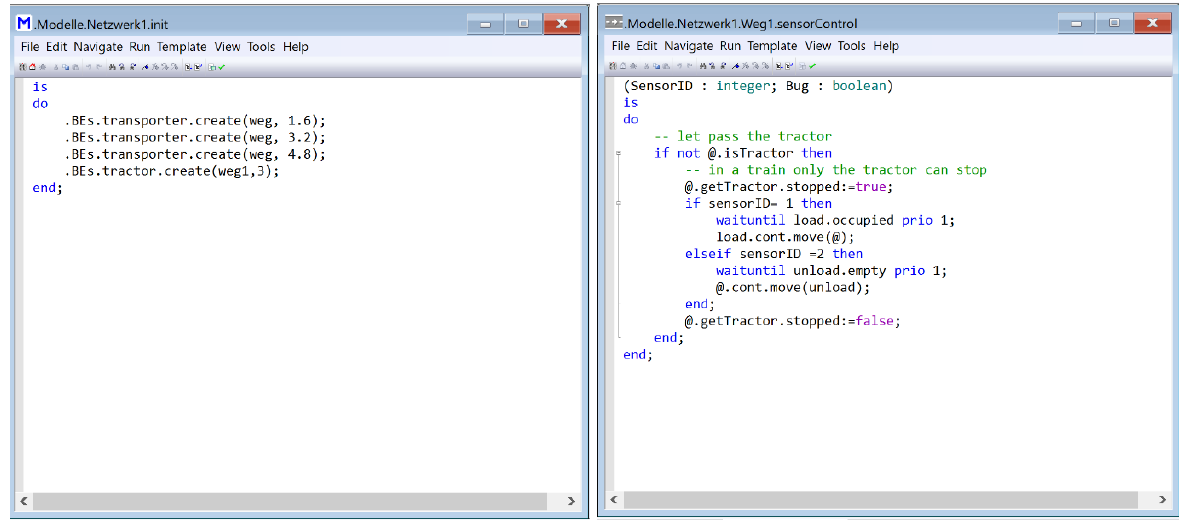
Figure 4: Examples of additional programming application in a simulation model.